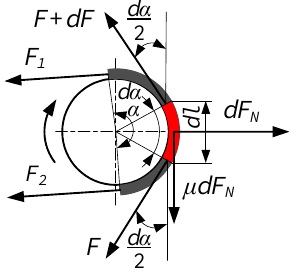
Figure 6. Tension analysis for belt drive.